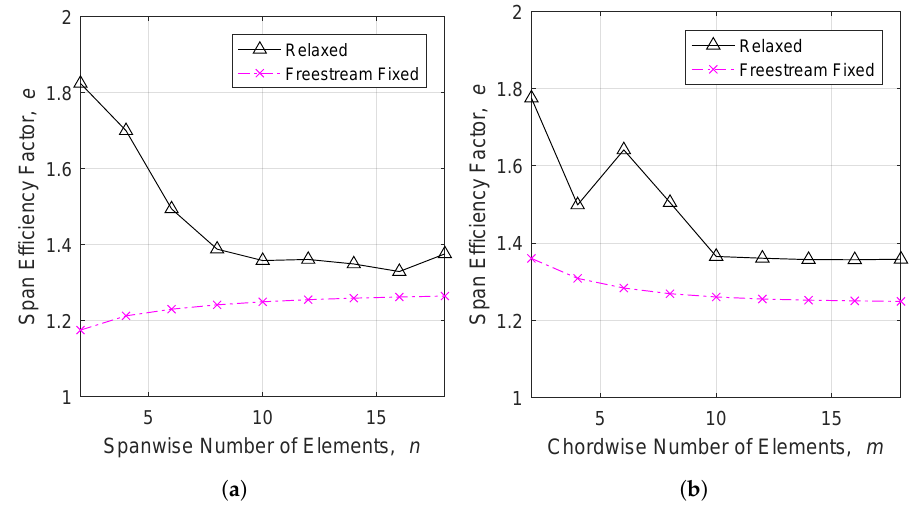
Figure 11. Convergence of the span efficiency factor as the number of elements is increased during an analysis of the NASA Trap Wing LaRC Configuration 1. ( a ) Varying number of spanwise elements, m = 12; ( b ) varying number of chordwise elements, n = 12.